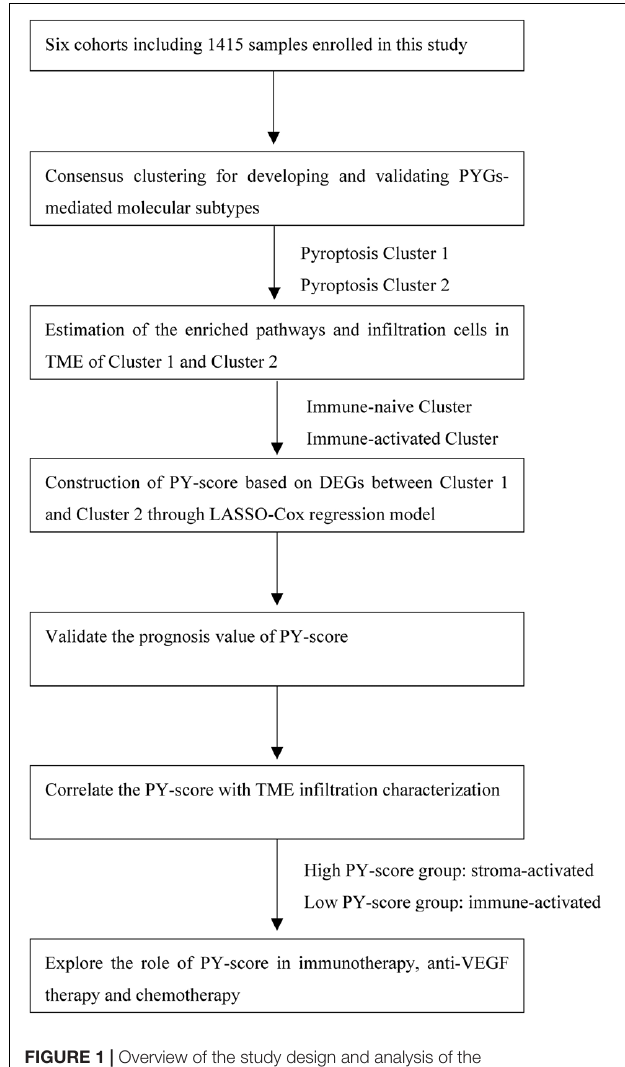
FIGURE 1 | Overview of the study design and analysis of the pyroptosis-related genes in colon cancer patients.